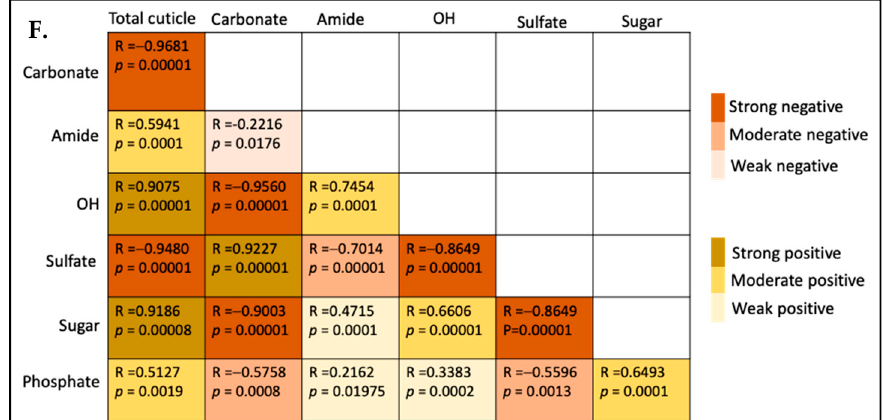
Figure 2. The intensity of ATR-FTIR spectroscopy peaks that were associated with the main components of the eggshell cuticle with the hen housing system ( n = 30): ( A ) Total cuticle, ( B ) Carbonates, ( C ) Sugars/polysaccharides, ( D ) Sulfates, and ( E ) OH, ( F ) The table of correlation. The correlation between the cuticle chemical components of the eggshell cuticle that was established using a linear regression (Y i = β 0 + β 1 X i ) in a curve fitting model using excel. The color coding indicates weak, moderate, or strong correlation between each chemical component of the cuticle. The values with different superscript letters (Tukey multiple means comparison) are significantly different (ANOVA; p < 0.05). The values represent the mean ± standard deviation ( n = 30 eggs/housing system).